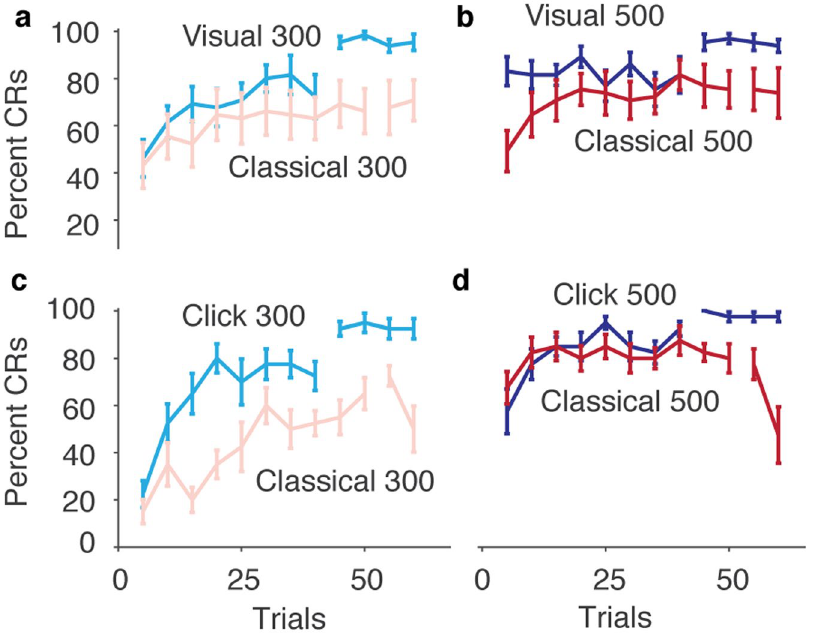
Figure 2. Learning curves. ( a – d ) Percentage of blink responses in successive blocks of five trials, that would be categorized as conditioned responses (CRs) according to standard criteria (a blink starting later than 150 ms after tone onset and before the target time or time of the air puff). The break in the lines indicate where Click or Visual feedback was ceased ( a and c ), or when the air puff was no longer delivered ( b and d